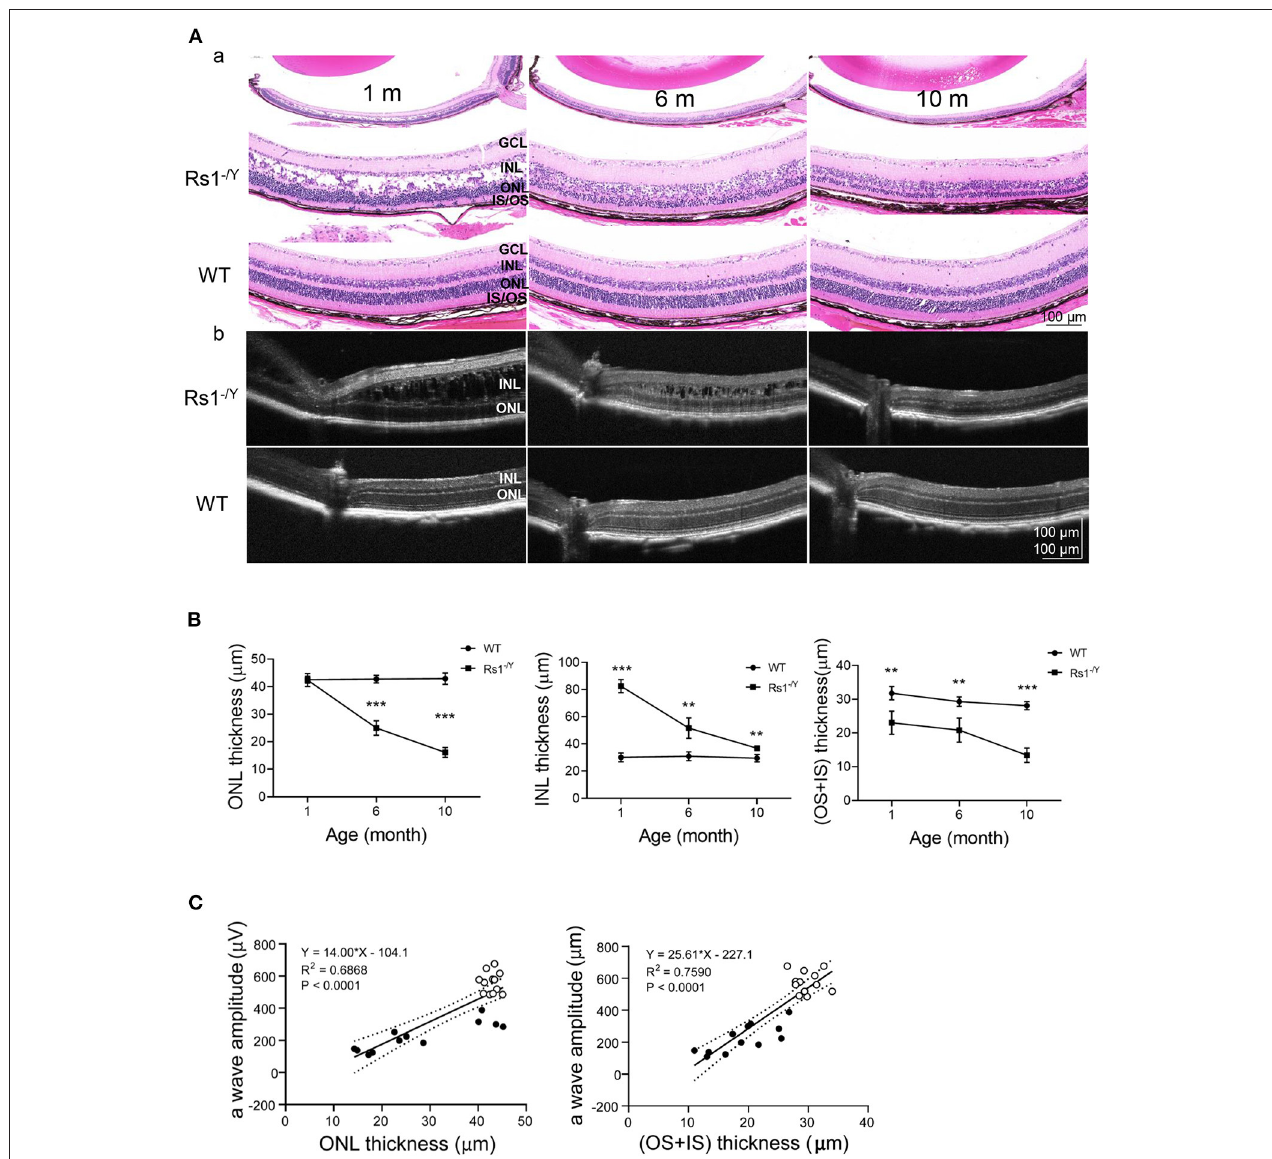
FIGURE 8 | Morphology changes in Rs1 − / Y mouse and age-matched WT mice. (A) Representative sections from retinas of 1, 6, and 10-month-old Rs1 − / Y mice and age-matched WT mice and retinal images obtained from OCT were used to evaluate the retinal morphology at three different ages. (B) The thickness of the ONL, INL, OS + IS 300 µ m away from the optic nerve was measured ( n = 4 at each age group). (C) a-Wave amplitude vs. OS + IS thickness. Lines : linear regression ( R 2 = 0.7590) and 95% confidence intervals. a-Wave amplitude vs. ONL thickness. Lines : linear regression ( R 2 = 0.6868) and 95% confidence intervals, P < 0.0001;